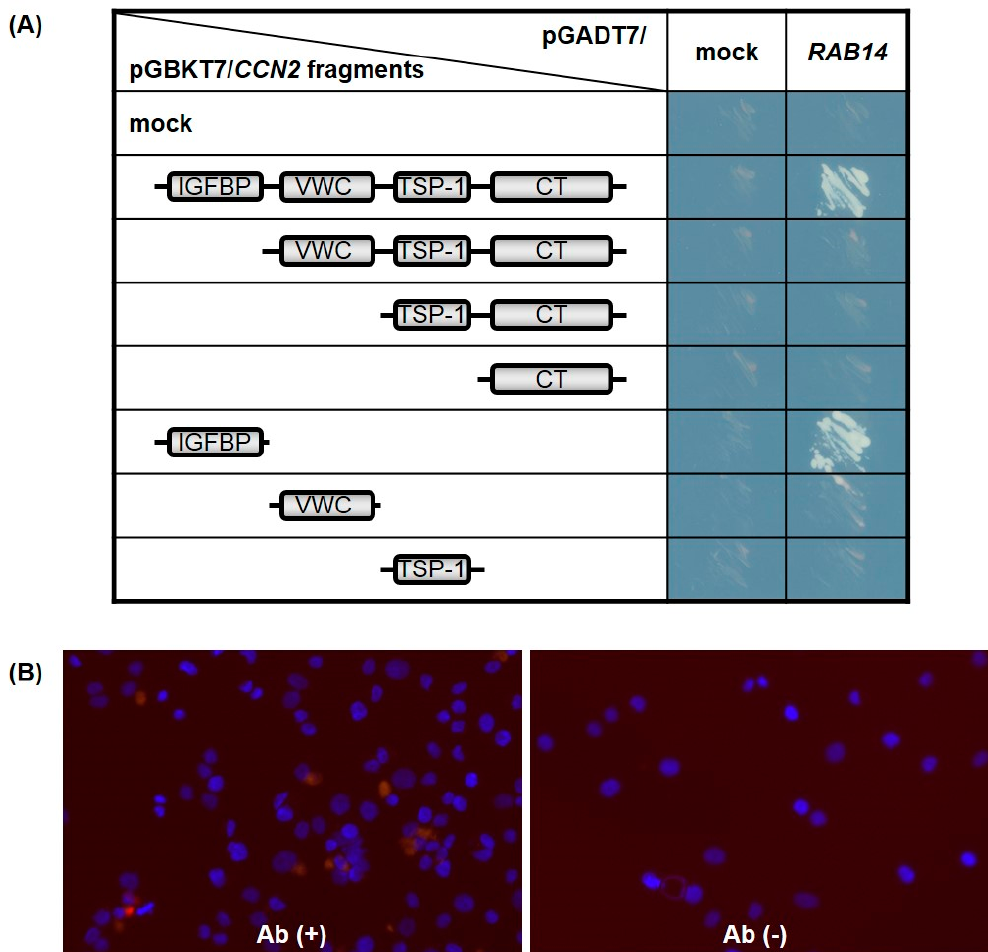
Figure 2. The cellular communication network factor 2 (CCN2) interaction domain with Rab14 GTPase (Rab14). Full-length CCN2 and its subdomains were expressed in the yeast cells as GAL4-BD fusion proteins, and full-length Rab14 was co-expressed as transcriptional activation domain fusion protein. The promoter activity induced by the interaction of both was monitored using independent reporter genes, such as histidine and adenine synthetase. Only transformants viable on synthetically defined medium lacking histidine and adenine were grown and visualized (mock: pGBKT7 or pGADT7 empty plasmid) ( A ). The interaction between CCN2 and Rab14 in HCS-2 / 8 cells was assessed by proximity ligation assay (PLA) technology (red, see result 2.2). Nuclei were visualized by DAPI (blue). Abbreviations: Ab ( + ), using α -CCN2 and α -RAB14 as primary antibodies; Ab (-), without primary antibody (negative control) ( B )